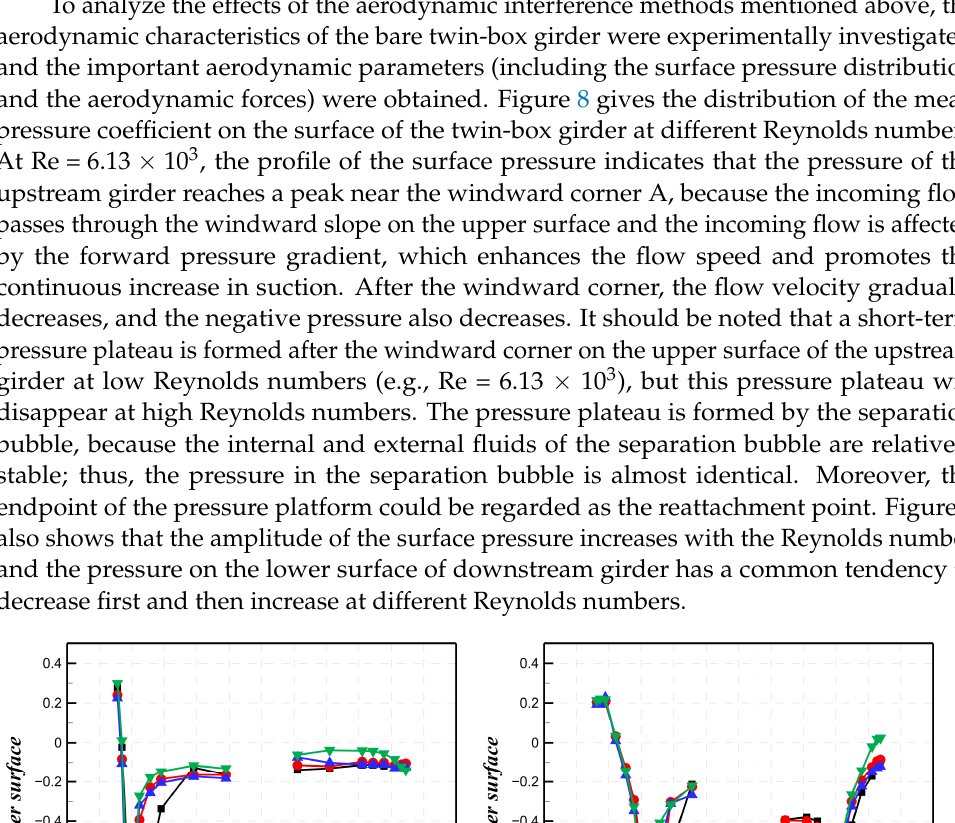
Figure 9. ( a – c ) The time-averaged drag force coefficient, time-averaged lift force coefficient, and time-averaged moment coefficient at different Reynolds numbers, respectively. ( d – f ) The fluctuating drag force coefficient, fluctuating lift force coefficient, and fluctuating moment coefficient at different Reynolds numbers, respectively. 3.2. Modulation of Surface Pressure Distribution by Leading Body-Height Grids First, the surface pressure distributions with the aerodynamic interference of the leading body-height grid were compared with those of the bare twin-box girder, as shown in Figure 10, and the effects of turbulence generated by different body-height grids on the surface pressure distribution were evaluated and analyzed. Figure 10 clearly shows that the turbulence intensity, which is an important charac- teristic of incoming flow, has a significant influence on the time-averaged surface pressure distribution. Compared with the surface pressure distribution of the bare deck, the char- acteristic of the pressure distribution with the body-height grid aerodynamic interference changed a lot at low Reynolds numbers (Re < 1.0 × 10 4 ), because the boundary layer tran- sitioned to the turbulent boundary layer. At low turbulence intensity ( I = 3.57%–5.15%), the amplitude of the pressure peak was enhanced. It is also noteworthy that, at the up- stream girder, the pressure plateaus (appearing in the undisturbed surface pressure dis- tribution) in the upper and lower surfaces were eliminated, because the vortices generated by the body-height grid broke the separation bubbles, and the laminar boundary layer